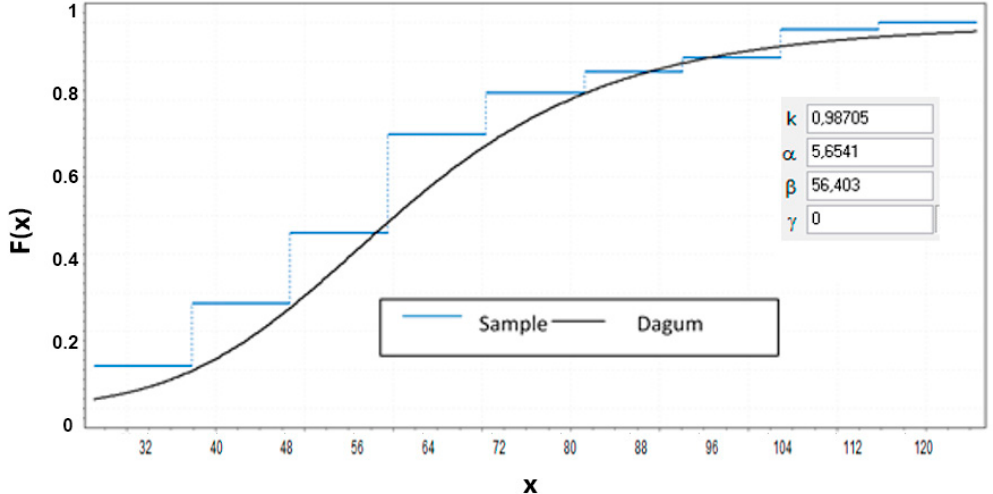
Figure 4. Cumulative distribution function for the Dagum distribution applicable to data from San Vicente de Alcántara.